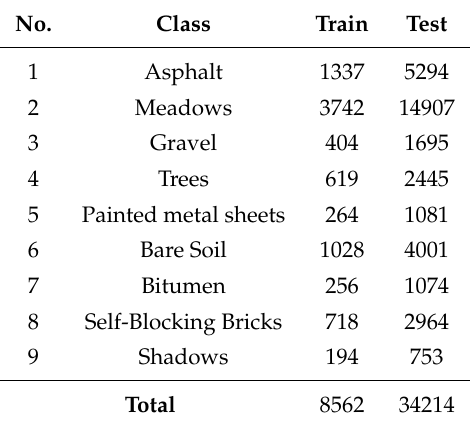
Table 2. The number of training and testing samples for the PaviaU dataset.